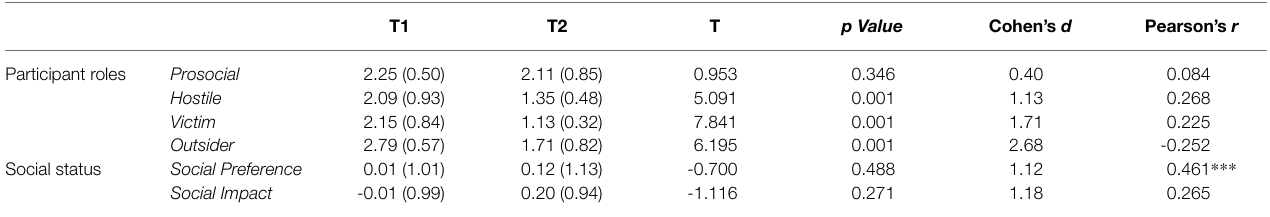
TABLE 2 | Mean scores (and standard deviations) on participant roles and social status measures at t1 and t2, T -test, and paired